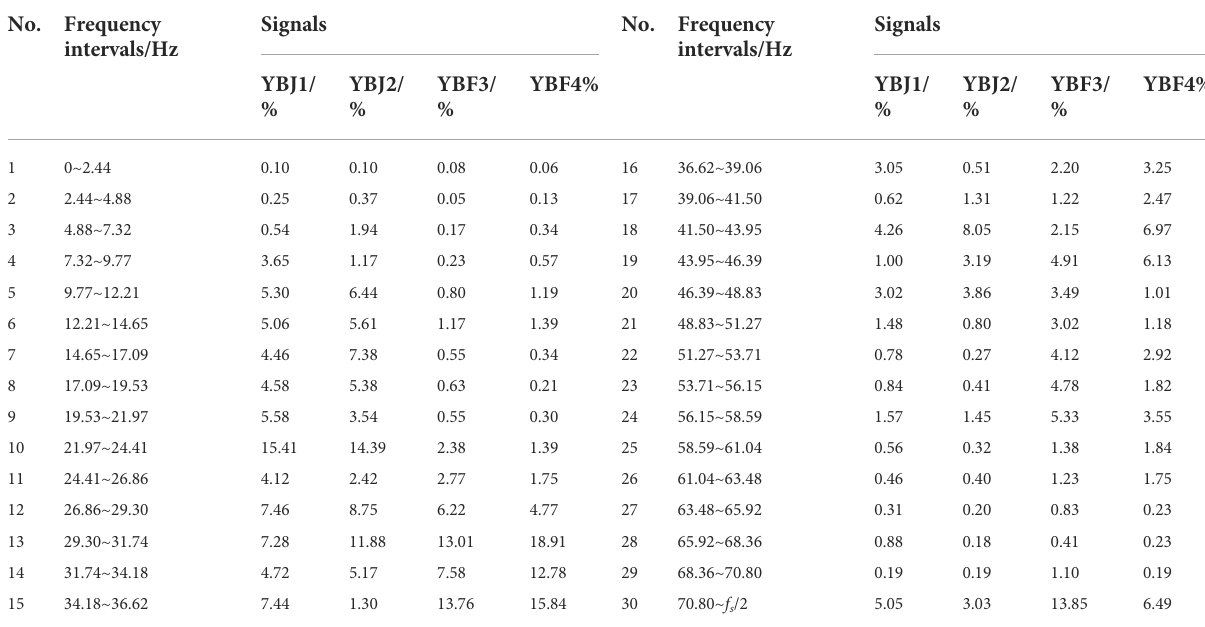
TABLE 2 Percentage of energy distribution in different frequency